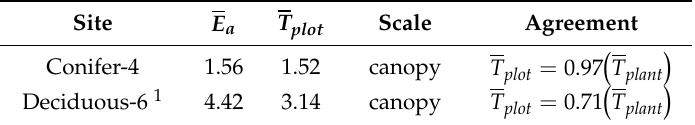
Table 5. E a and T plot at the Coniferous (8 days average) and Deciduous (4 days average) sites. SA plot was used as the unit ground area to estimate T plot . All estimates in mm / d. Site E a T plot Scale Agreement Conifer-4 1.56 1.52 canopy T plot = 0.97 Deciduous-6 4.29 3.14 canopy T plot = 0.73 Deciduous-6 1 5.31 3.14 canopy T plot = 0.59 1 When K VPD = 0.79 kPA. Table 6. T plant and T plot at the Coniferous (8 days average) and Deciduous (4 days average) sites. SA plot was used as the unit ground area to estimate T plot . All estimates in mm / d. Site E a T plot Scale Agreement Conifer-4 1.56 1.52 canopy T plot = 0.97 Deciduous-6 1 4.42 3.14 canopy T plot = 0.71 1 When K VPD = 0.84